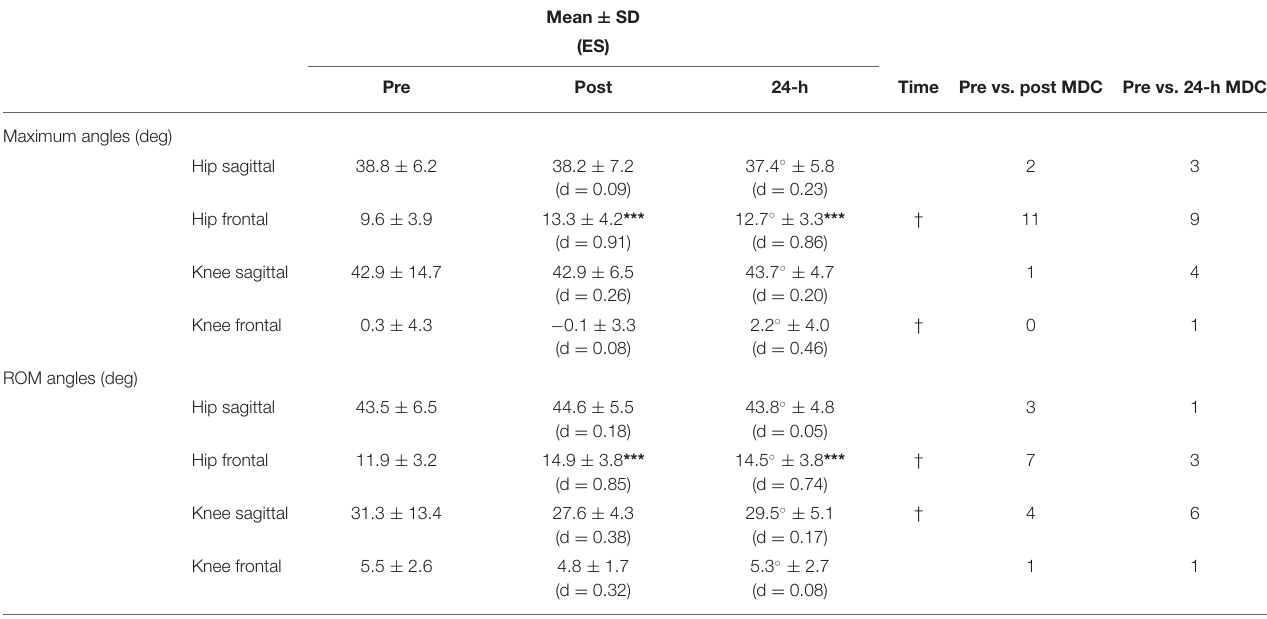
TABLE 4 | Hip and knee joint kinematics of maximal angles and range of motion (RoM) angles in the sagittal and frontal plane movements of standard pace run represented as mean standard deviation for pre, post, and 24-h post training run along with effect size (ES; Cohen’s d ) and individuals exceeding minimum detectable ± change (MDC) for each variable at post and 24-h post compared to